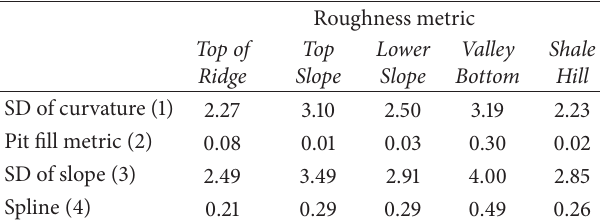
Table 4: Mean values of roughness metrics by landform delineated by roughness